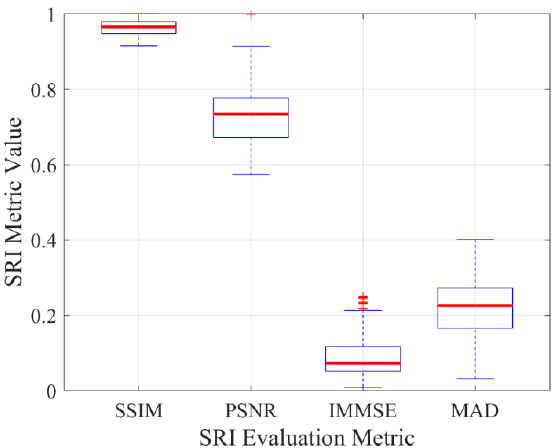
Figure 15. Evaluation results for SRI performances of proposed method for 121 sub-aperture + 1 maximum images × 18 objects = 2196 images for all objects (O#1–O#18) combined using different SRI